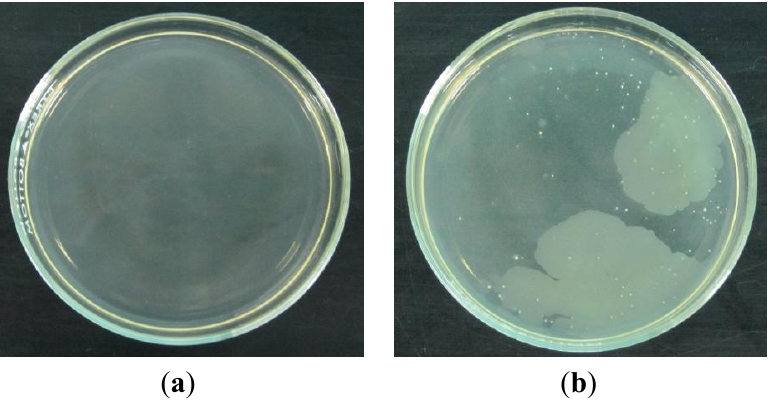
Figure 2. Agar plates used as control for comparison: ( a ) Agar plate without bacteria; ( b ) Agar plate with bacteria.